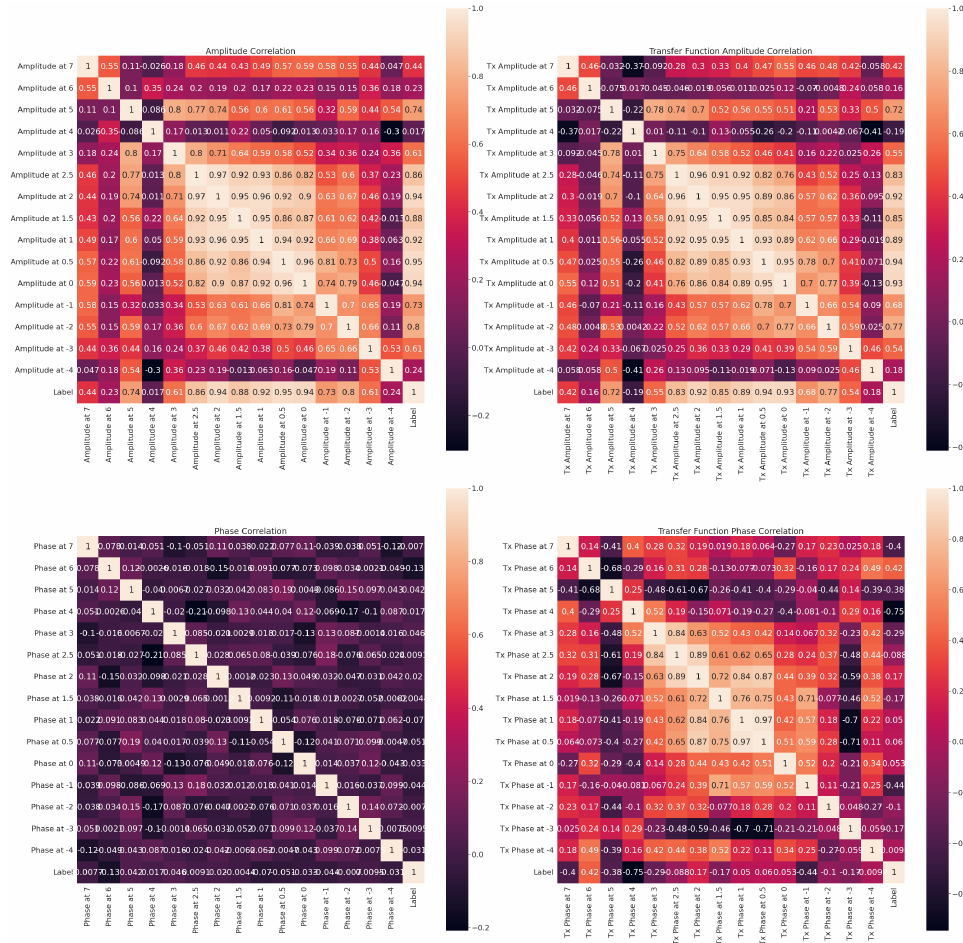
Figure 18. The correlation matrices for the Amplitude data ( top left ), the Transfer Function Amplitude data ( top right ), the Phase data ( bottom left ), and the Transfer Function Phase data ( bottom right ) for the set of Hole, No Hole, or Hole Filled